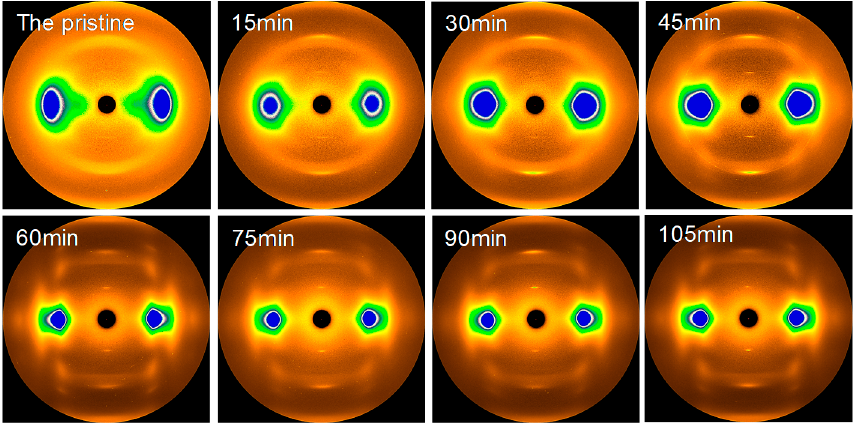
Figure 6. The two-dimensional (2D) wide angle X-ray scattering (WAXS) patterns of the pristine and treated F-III fibers in Sc-CO 2 .